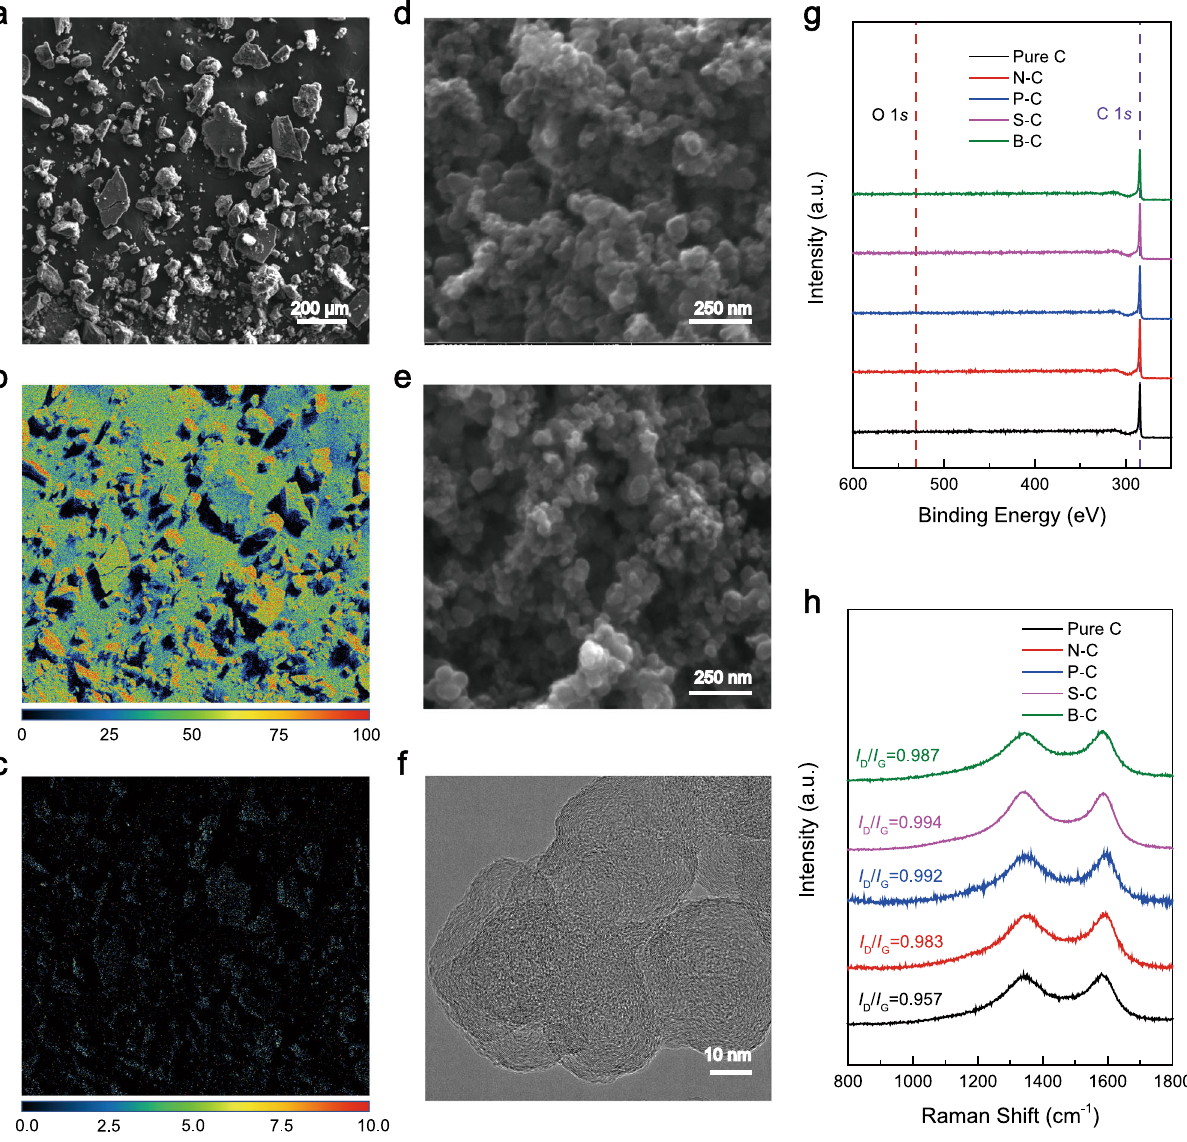
Fig. 2 Characterizations of the catalysts. a Back-scattered electron (BSE) image of B – C and corresponding wavelength-dispersive spectroscopy (WDS) elemental mapping for ( b ) carbon and ( c ) boron. The color bars below represent the atomic ratio (%) for each element. d , e Morphology of Pure C and B – C, respectively, from SEM. The scale bar represents 250 nm. f High-resolution TEM image of B – C, with the scale bar representing 10 nm. g XPS survey scan with C and O peak positions emphasis. Note that there is no obvious peak for O, indicating that our sample preparation process effectively removes the surface oxygen from the catalysts, maximally excluding the effects from surface oxygen on 2e − -ORR performance. h Raman spectroscopy for catalysts. The I D / I G ratios are similar for all the samples, excluding the effect of defect concentration difference. Note that a.u. represents arbitrary